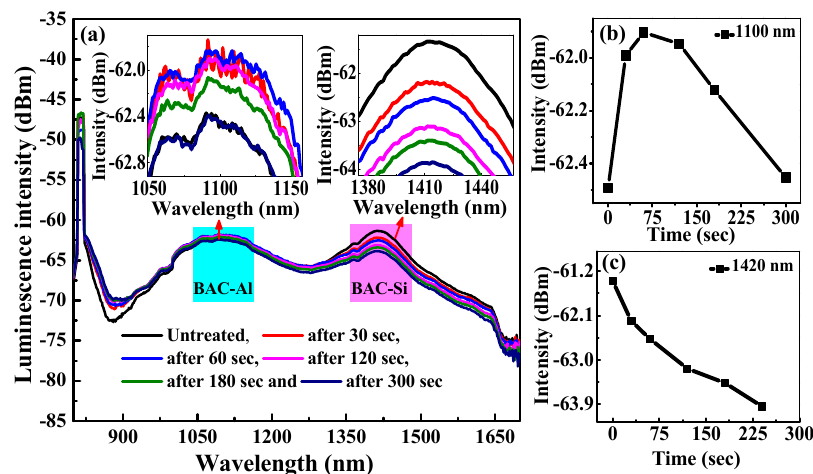
Figure 3. ( a ) Change of the luminescence spectra of Bi-doped fibers with an 830 nm pump excitation only after UV irradiation treatment. And the inserts are enlarged luminescence spectra from 1050 nm to 1150 nm (left) and 1380 nm to 1460 nm (right). ( b ) The change of luminescence intensity at ~1100 nm. ( c ) The change of luminescence intensity at ~1420 nm.